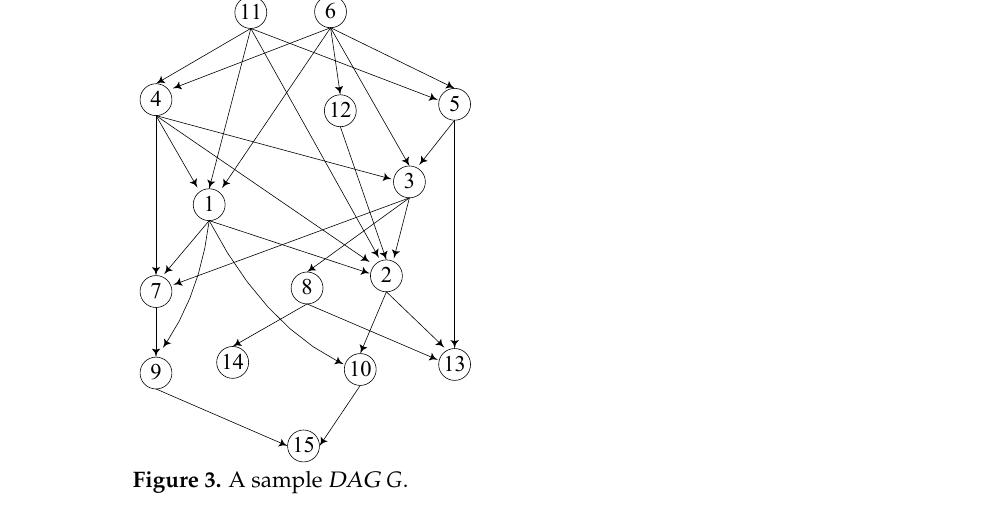
Table 1. The p2HL s L 1 , L 2 , L 3 constructed based on S 1 = { v 1 } , S 2 = { v 1 , v 2 } , and S 3 = { v 1 , v 2 , v 3 } , respectively.